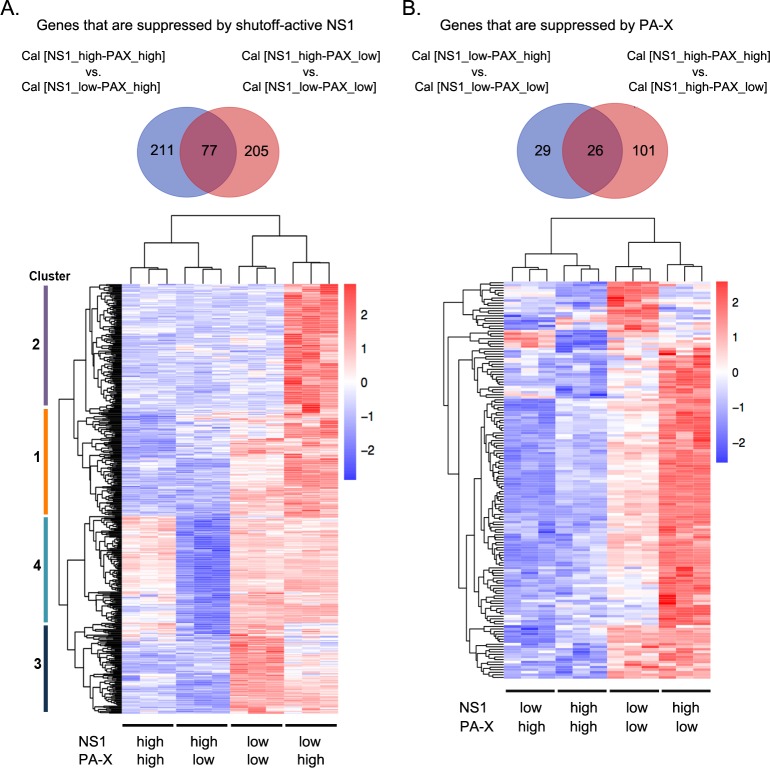
Analysis of genes suppressed by active NS1 or PA-X.Genes suppressed by shutoff-active NS1 (A) or PA-X (B) are shown. A Venn diagram demonstrates number of genes suppressed by NS1 or PA-X at least two-fold. Heatmaps show the 493 (A) or 156 (B) DEGs. Each row represents each gene (blue: low expression; red: high expression; Z-score scaling from -2 to 2). Each column represents one replicate from each virus group. Shutoff activity elicited from PA-X and active NS1 was noted under each virus-infected conditions. Hierarchical clustering was performed and cluster numbers based on their expression profiles were demonstrated on the left of the heatmap (A).